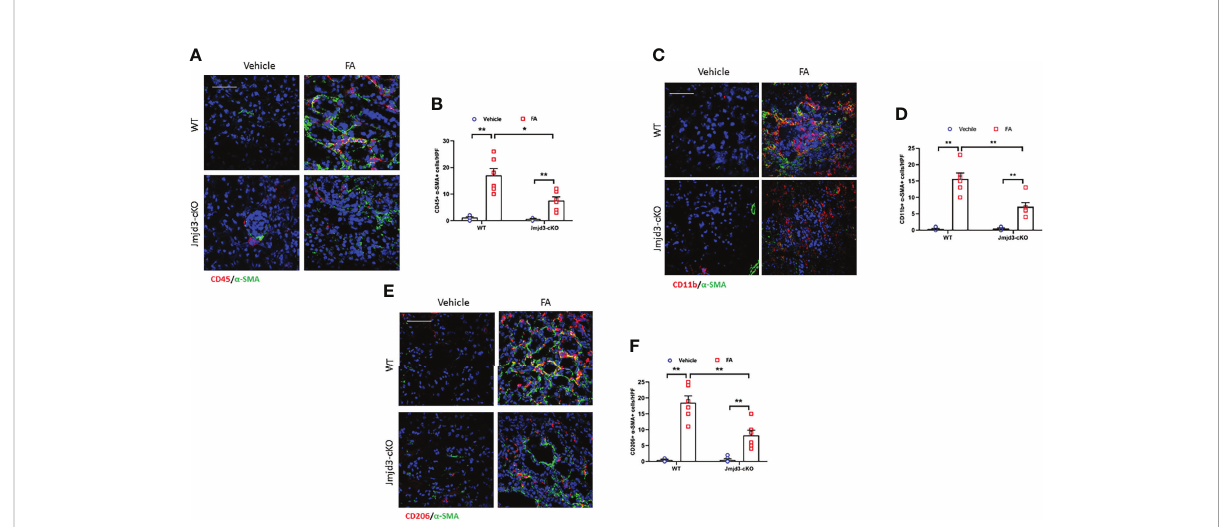
FIGURE 2 Myeloid Jmjd3 deletion inhibits myeloid myo fi broblast accumulation and M2MMT in kidneys with FA injury. (A) Kidney sections iwere stained for CD45 (red) and a -SMA (green). (B) Quantitative analysis of CD45 + - a -SMA + cells in kidneys with or without FA injury. (C) Kidney sections were stained for CD11b + - a -SMA + cells in kidneys with or without FA injury. (D) Quantitative analysis of CD11b + - a -SMA + cells in kidneys with or without FA injury. (E) Kidney sections were stained for CD206 (red) and a -SMA (green). (F) Quantitative analysis of CD206 + - a -SMA + cells in the kidneys with or without FA injury. * P <0.05 or ** P <0.01; n=6; Bar = 50 m m. M2MMT=M2 macrophage to myo fi broblast transition; WT, wild-type; cKO, conditional knockout; HPF, high-power fi